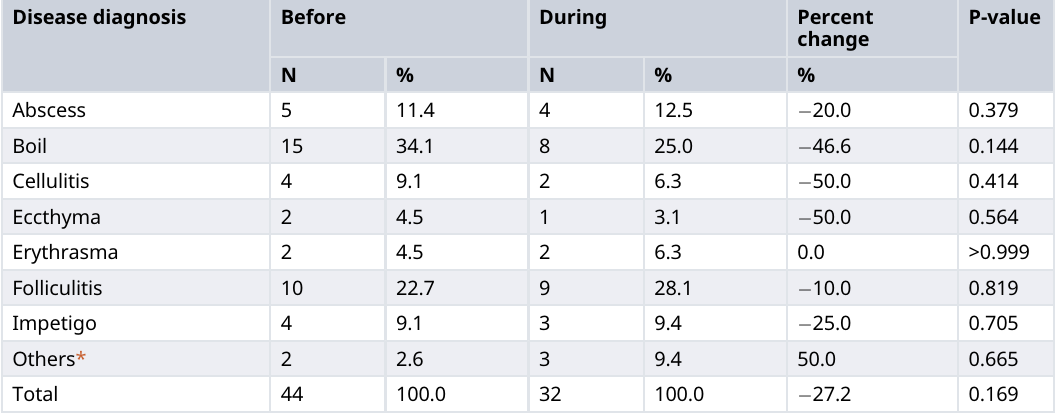
Table 3. The types of cutaneous bacterial infections before and during coronavirus disease 2019 (COVID-19) pandemic. Disease diagnosis Before During Percent